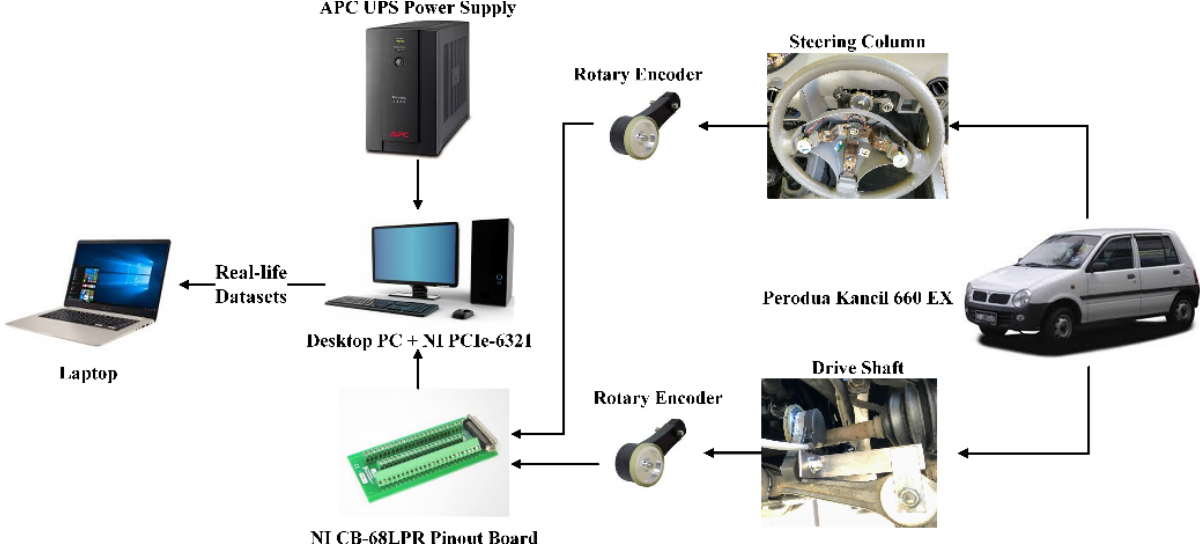
Figure 5: Experimental testbed for acquiring steering wheel angle and vehicle speed